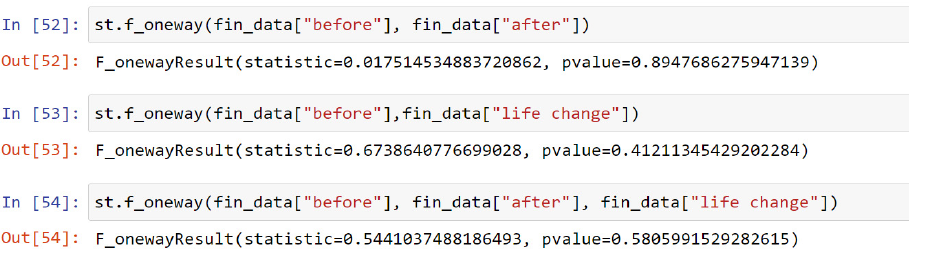
Figure A9. ANOVA calculation via Jupyter Notebook and statistical functions (scipy.stats). Source: own research. Table A1. Preferred FINTECH applications before and after the COVID-19 crisis. Source: own research. * Value counts in absolute value; more than one answer was possible. Which FINTECH Have You Used before Which FINTECH Have You Used